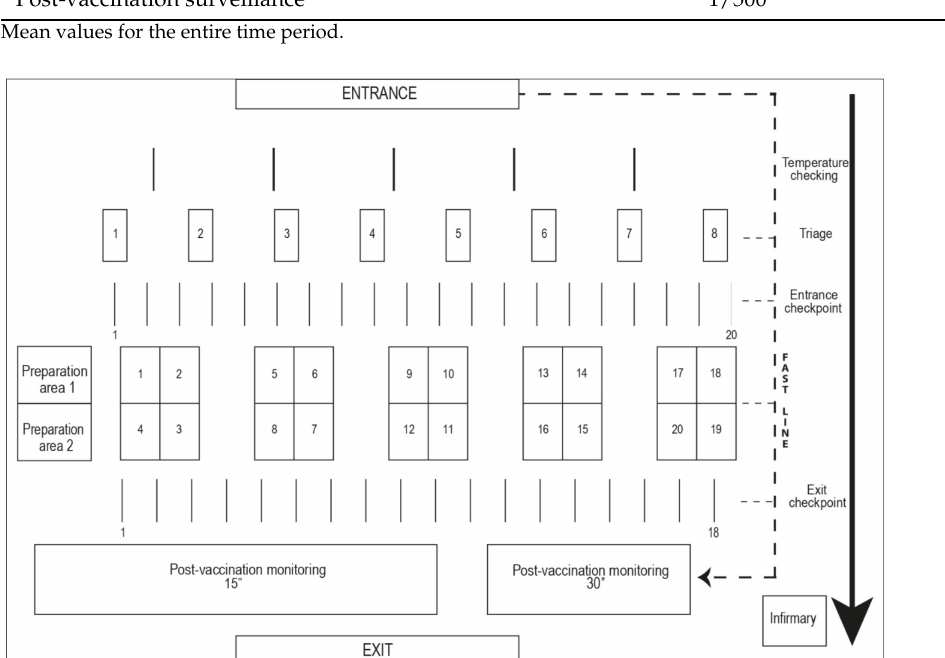
Figure 2. Toulouse Mass Vaccination Center geographical design. Every vertical line represents a station at each step of the process. For example, there are five stations at the temperature checking. Numbers correspond to the different stations in a specific